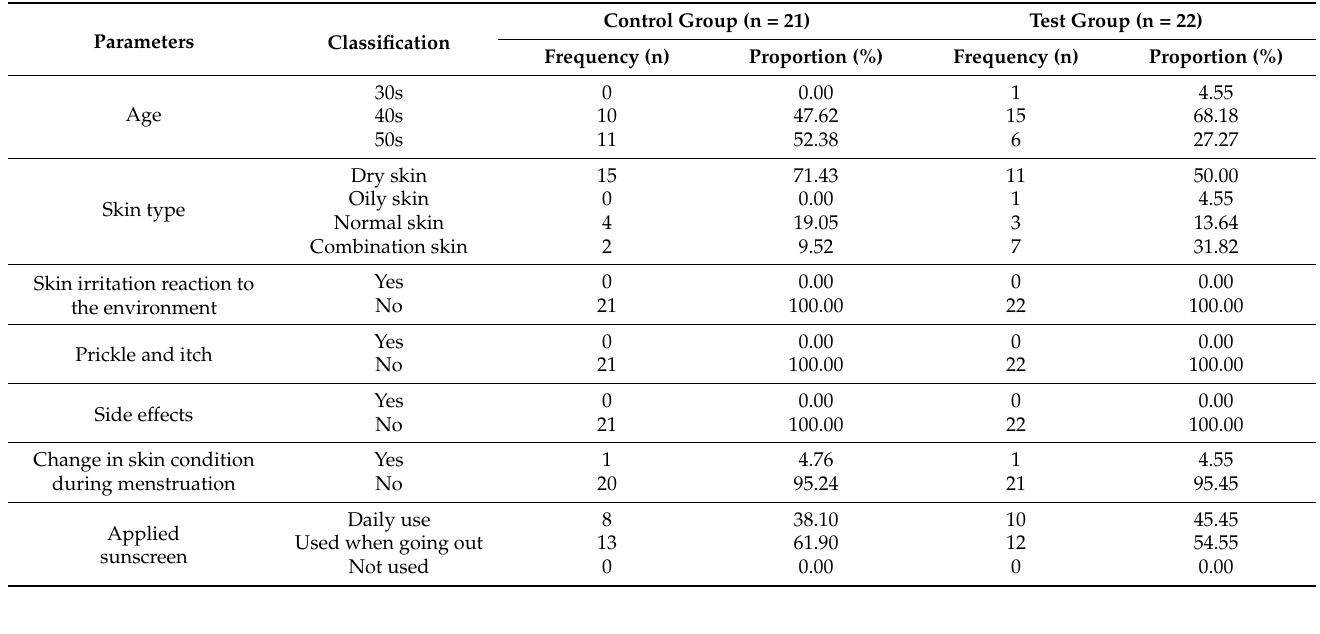
Table 2. Characteristics of the volunteers.